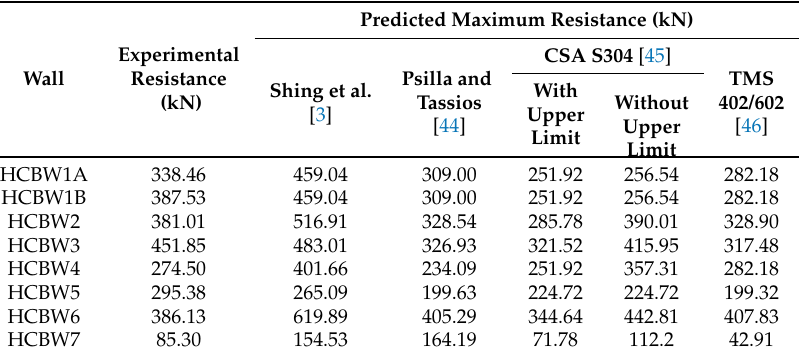
Figure 16. ( a ) Prediction of resistance with different expressions; and ( b ) prediction errors. Table 6. Prediction of the resistance of the tested